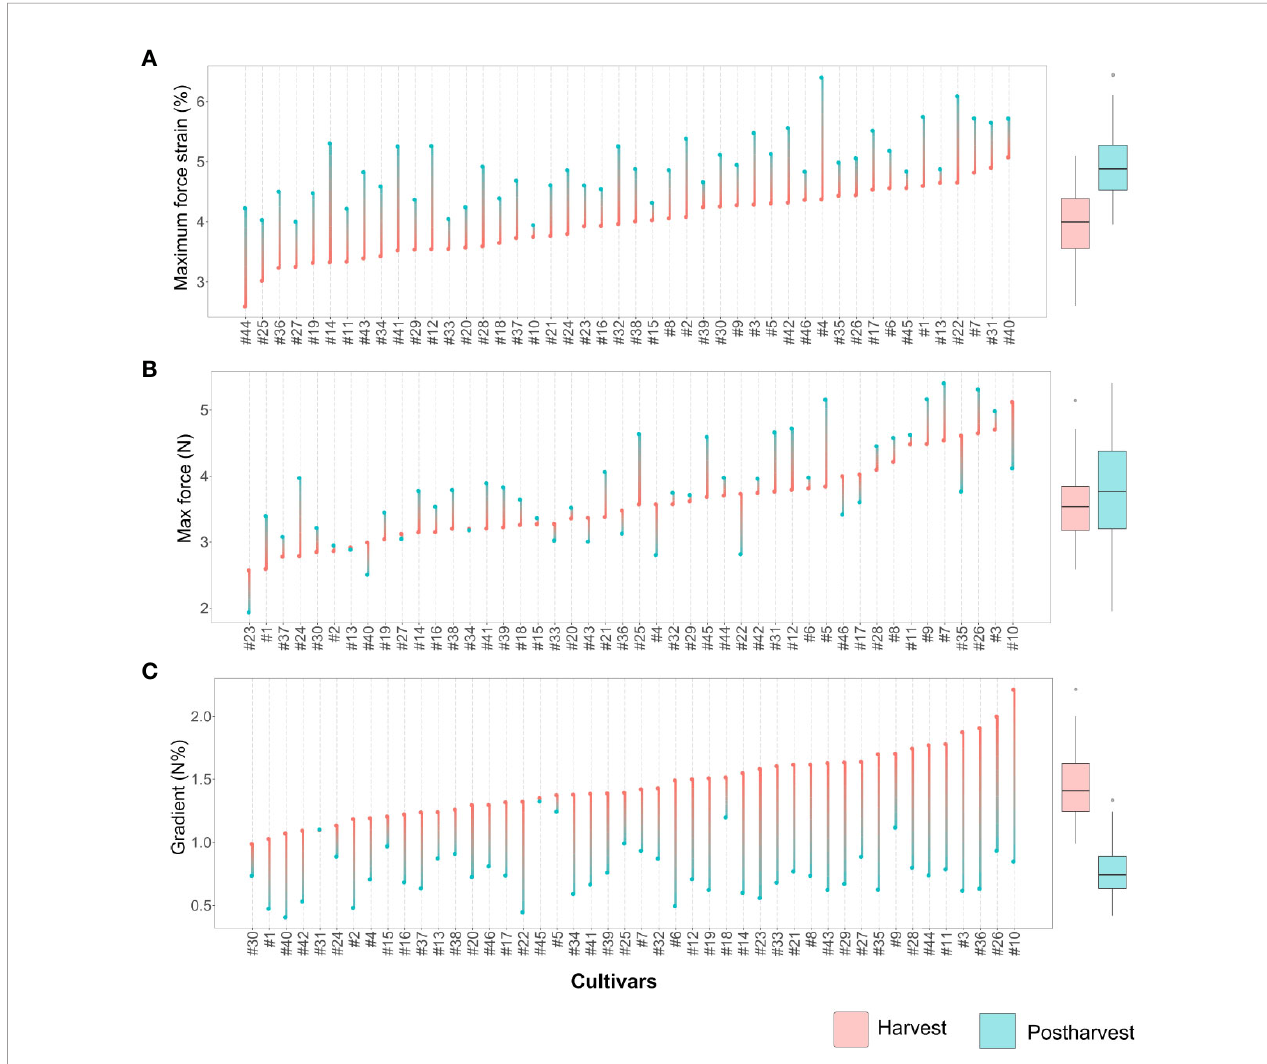
FIGURE 3 | Lollipop graph and box plot of three texture parameters: (A) Maximum force strain, (B) Maximum force, (C) Gradient. Each graph illustrates the average value (of 20 measurements) recorded at harvest and after 6 weeks of storage, for each cultivar (names of the cultivars are reported in Table 1 ). For graphical purpose, cultivars of each graph are ordered based on the trait level recorded at harvest. The box plot, reported next to each lollipop graph, summarise the differences between fruit assessed at harvest and after storage. Lollipop graphs, together with distribution plots and box plots of all 7 texture parameters, are reported in Figure S1